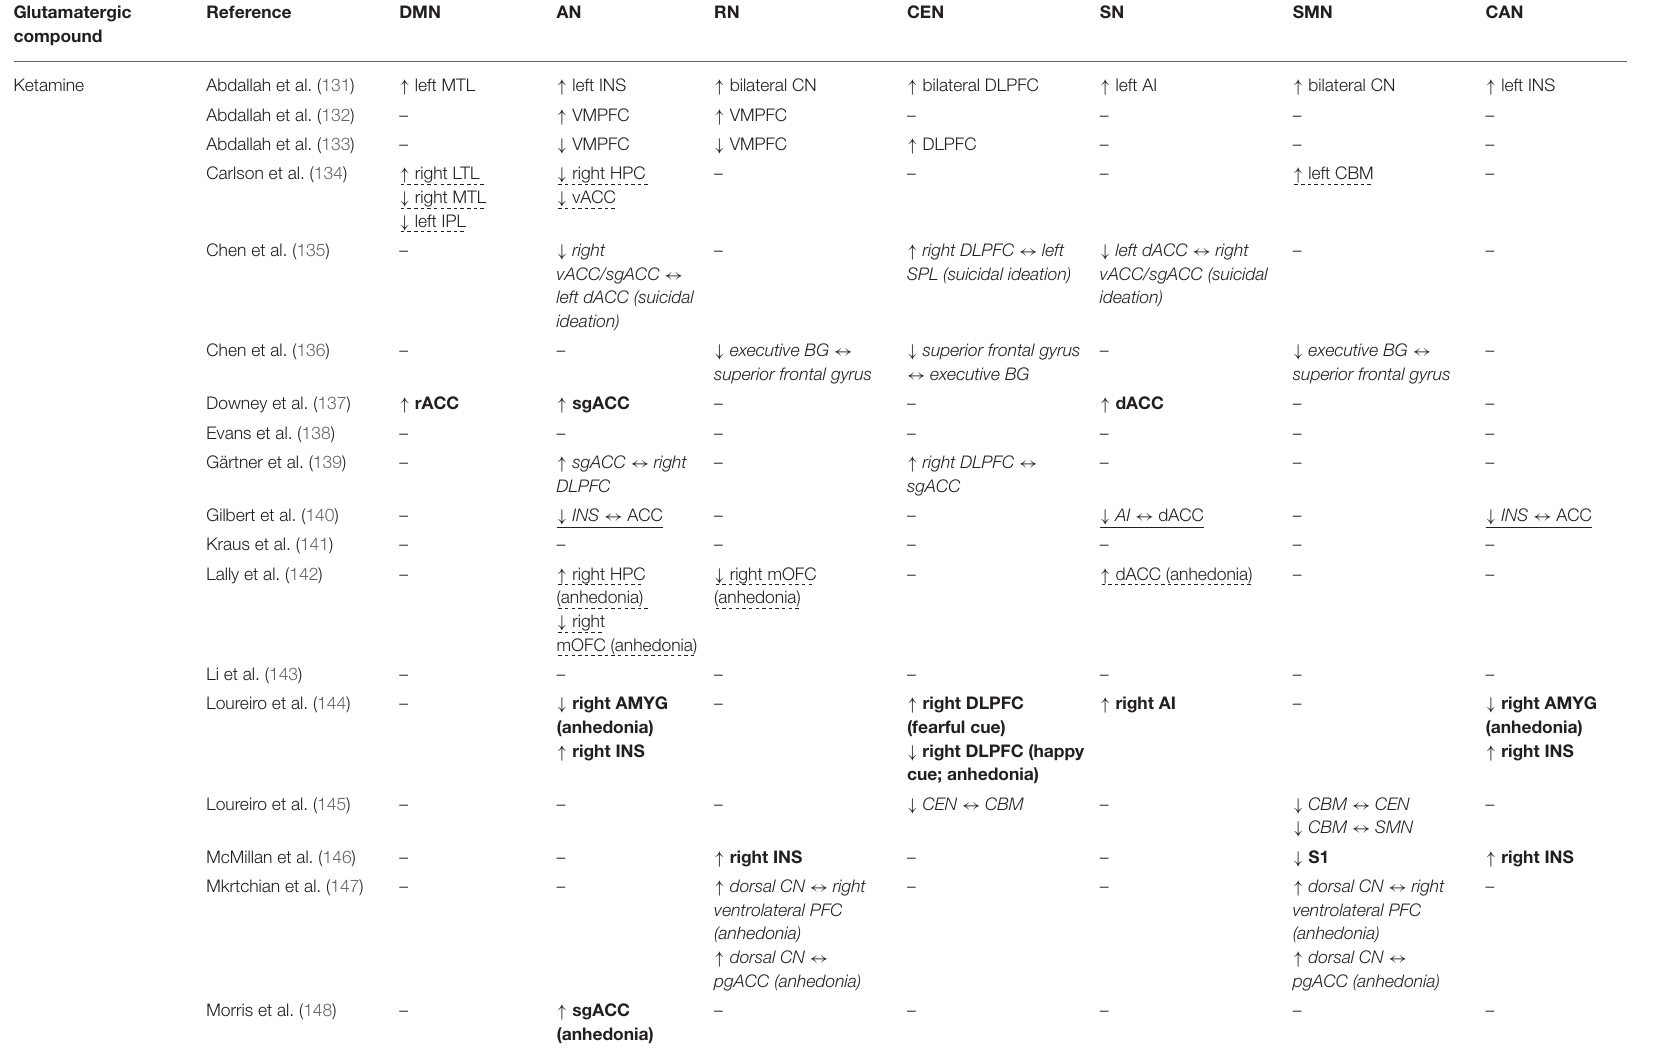
TABLE 4B | Intrinsic connectivity network biomarkers predicting antidepressant response to glutamatergic interventions. Glutamatergic